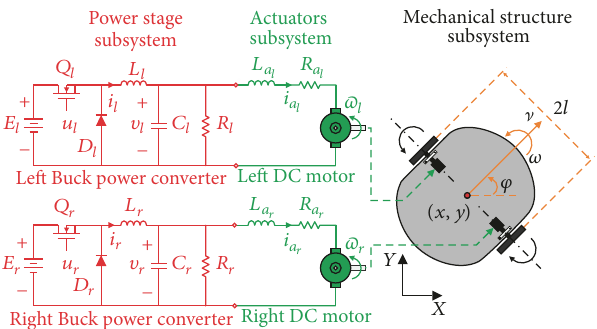
Figure 1: WMR complete